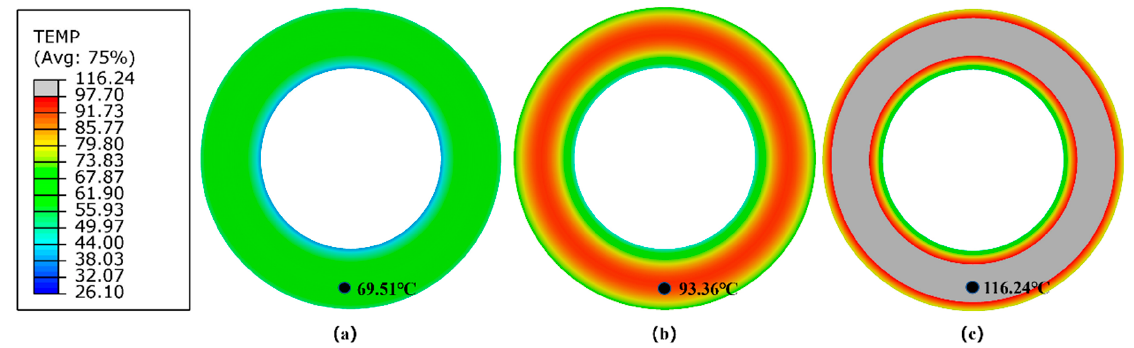
Figure 18. Contour plots of steady-state surface temperature of the Plane Strain finite element tire